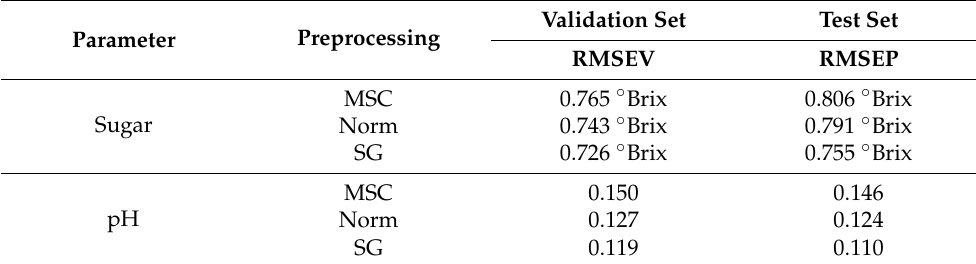
Table 4. Model performance of the optimized 1D CNN for each preprocessing method.